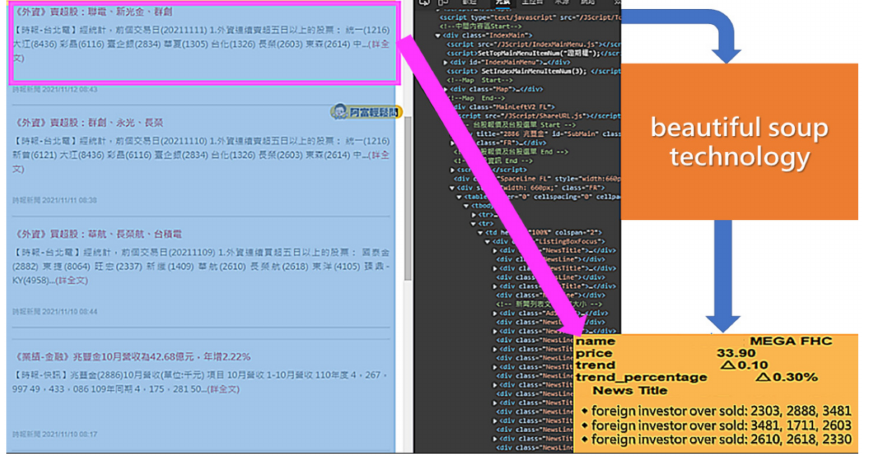
Figure 6. Processing of stock news scraping with beautiful soup.